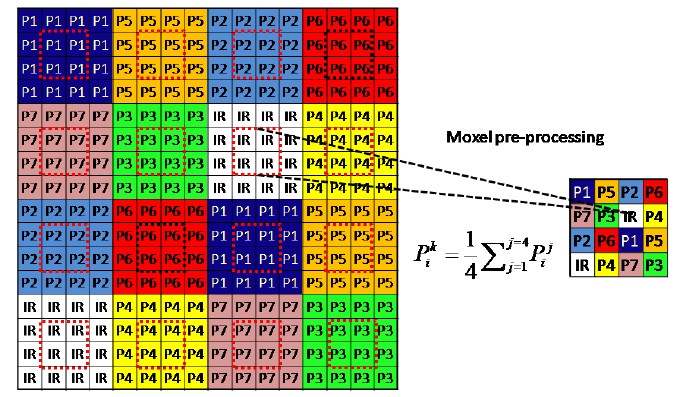
Figure 5. Pre-processing (downsampling) applied before using pixel values of images. We select the four center pixels to filter the spatial non-uniformity related to each spectral